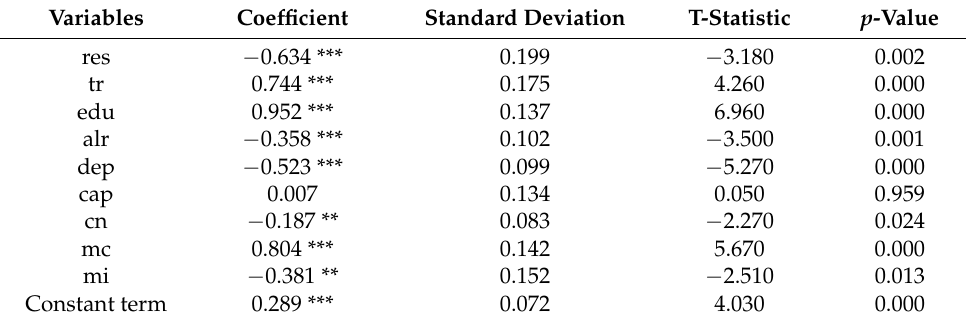
Table 6. Robustness regression